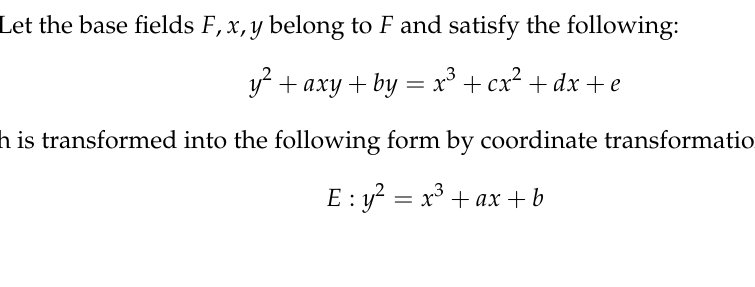
Figure 2. Point-plus geometric